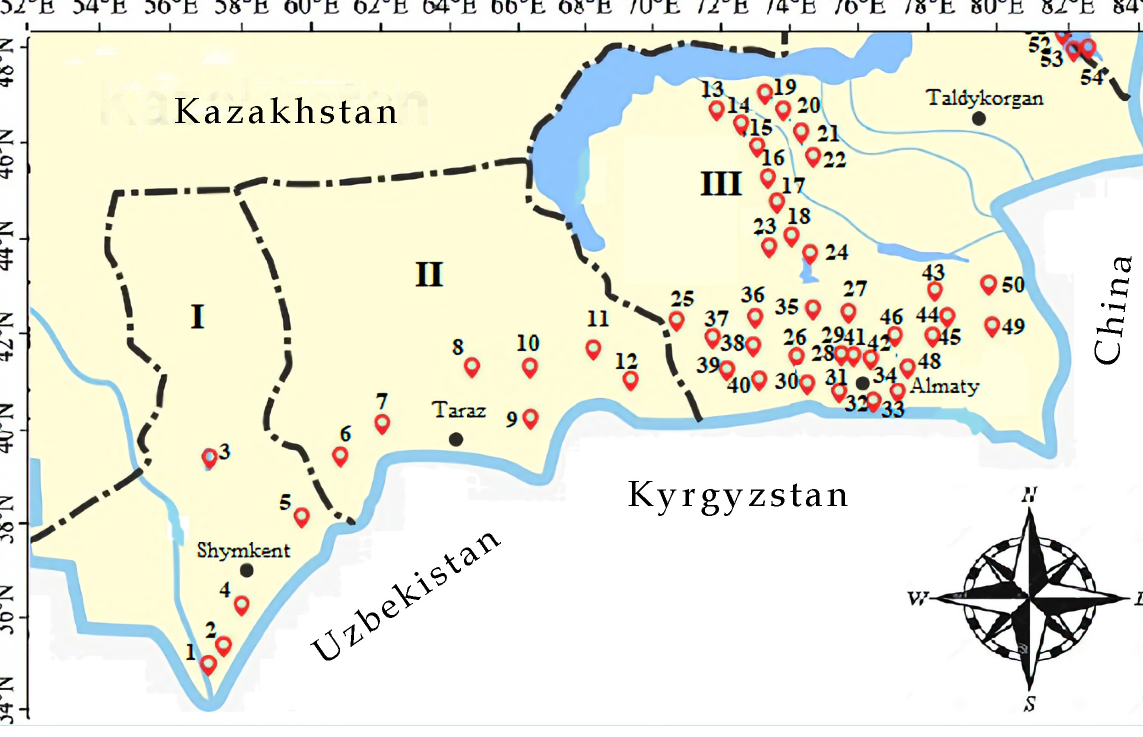
Figure 9. The surveyed localities (54 study sites) in southern and southeast Kazakhstan in Turkestan (I), Zhambyl (II), and Almaty (III) administrative regions in June–October of 2019–2022.